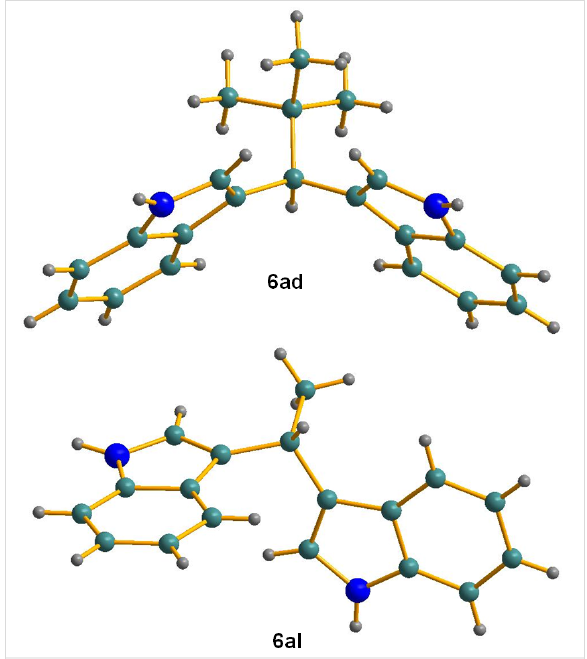
Figure 2: Crystal structures for compounds 6ad and 6al